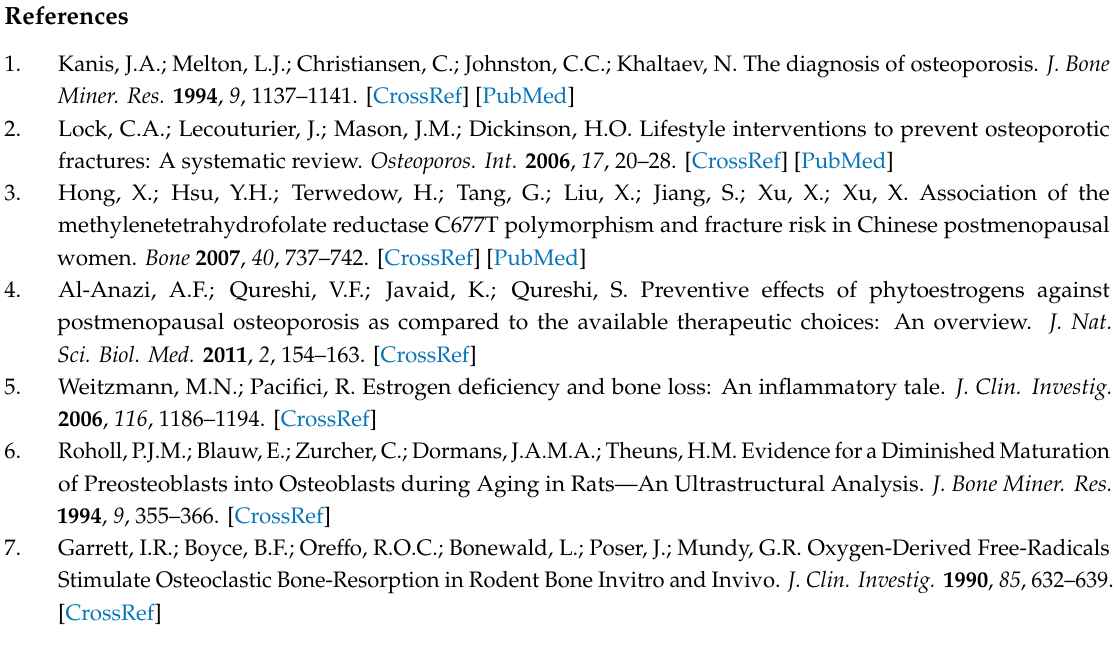
Figure S1: Base peak chromatograms of lipid standards in (a) positive- and (b) negative-ion mode of nUHPLC–ESI–MS / MS. Figure S2: BPC’s of lipid extracts from HDL and LDL fraction of a plasma sample pooled with patients (PMOp) and controls obtained by nUHPLC–ESI–MS / MS. Figure S3: Stacked bar graphs of lipid species, showing the summed amounts of ( > 1.5-folds and p < 0.05) in PMOp ( n = 10) groups in comparison to controls ( n = 10). Figure S4: Heatmap of selected lipid species, showing the significant di ff erence ( > 1.5-fold and p < 0.05) in PMOp ( n = 10) groups in comparison to controls ( n = 10). Table S1: Demographic data for control and PMOp patients. Table S2: List of lipid internal standards and their precursor ion, product ion, and collision energy used in SRM quantification process. Table S3: Limit of detection (LOD) and limit of quantification (LOQ) of lipid standard lists spiked to each lipid extract. Table S4: Corrected peak area value and fold ratio (PMOp / Control) of identified lipids in HDL and LDL fractions obtained by nUHPLC–ESI–MS / MS. Table S5: Potentially available acyl chains of (a) PC, (b) PE and (c) TG based on CID spectra using nUHPLC–ESI–MS / MS. Table S6: Relative ratio (PMOp / control) of lipid amounts in each lipoprotein fraction between PMOp and control groups selected for lipid species showing significant changes ( > 1.5-fold and p -value < 0.05, marked with *) either in HDL or LDL fraction of